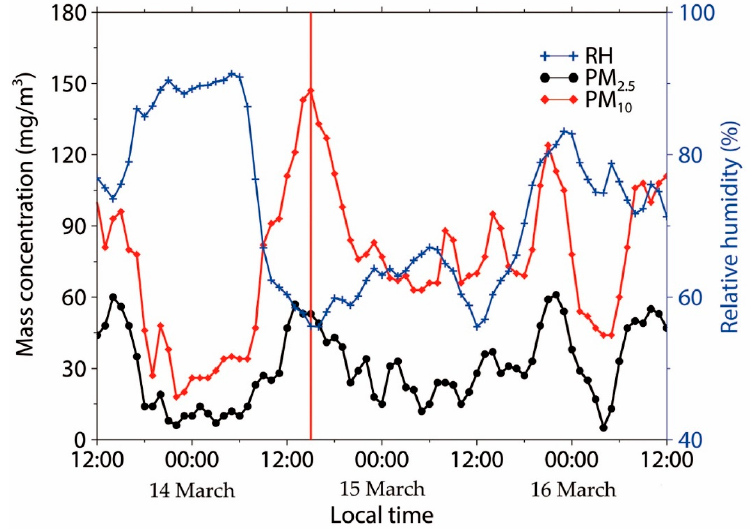
Figure 1. In situ measurements of the diurnal variations in PM 10 , PM 2.5 , and relative humidity (RH) near the ground surface in Chungli, Taiwan during 13–16 March 2009. The red and black lines represent the mass concentrations of PM 10 and PM 2.5 , respectively, and the blue line shows the variation in RH. The peak of PM 10 is indicated by a vertical red line.